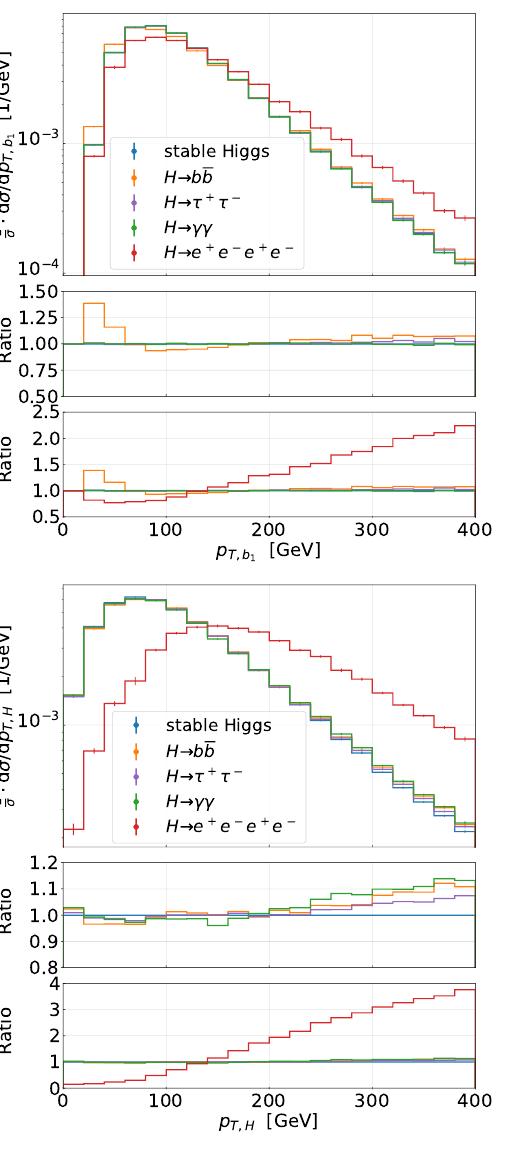
Figure 16 . Normalised differential distributions for the observables p T,b cos ( θ b ) for the pp → e + ν e µ − ¯ ν µ b ¯ b H process at the LHC with 1 b 2 µ 0 = H T / 2 and µ R, dec = m H . The NNPDF3.1 PDF set is employed. The case of the stable